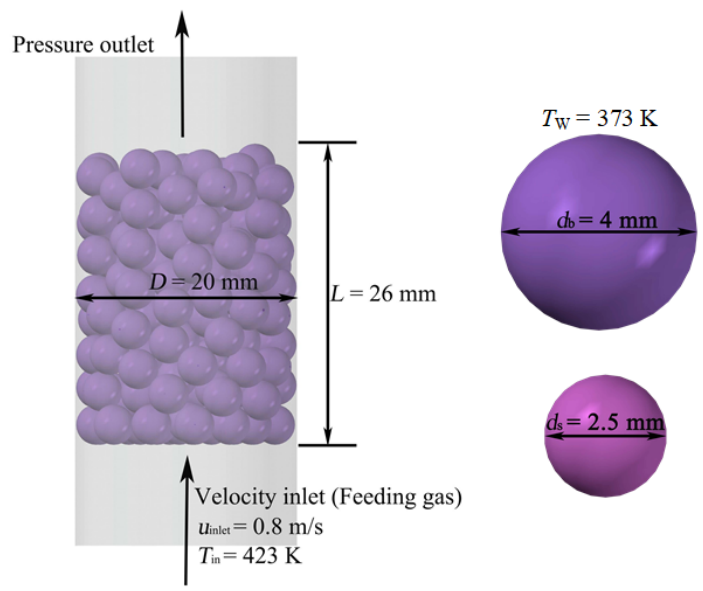
Figure 3. Computational physical mode.